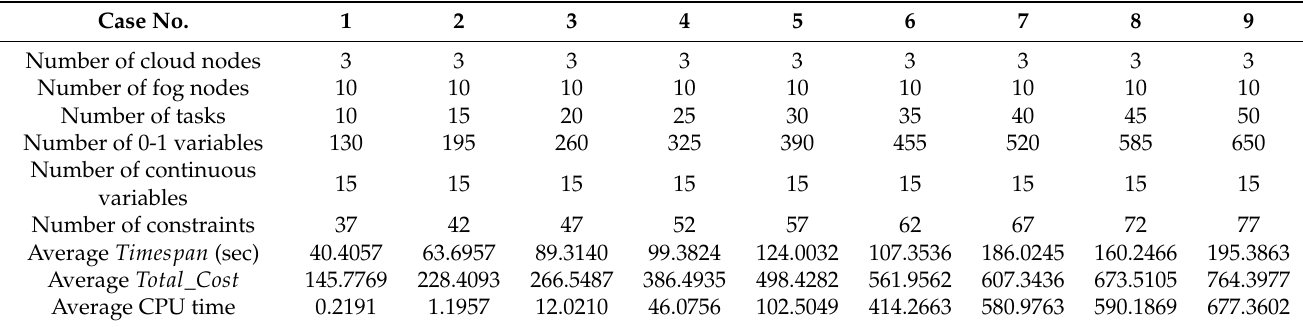
Table 3. Experimental results of the proposed method for 3 cloud nodes and 10 fog nodes (dataset 1). Case